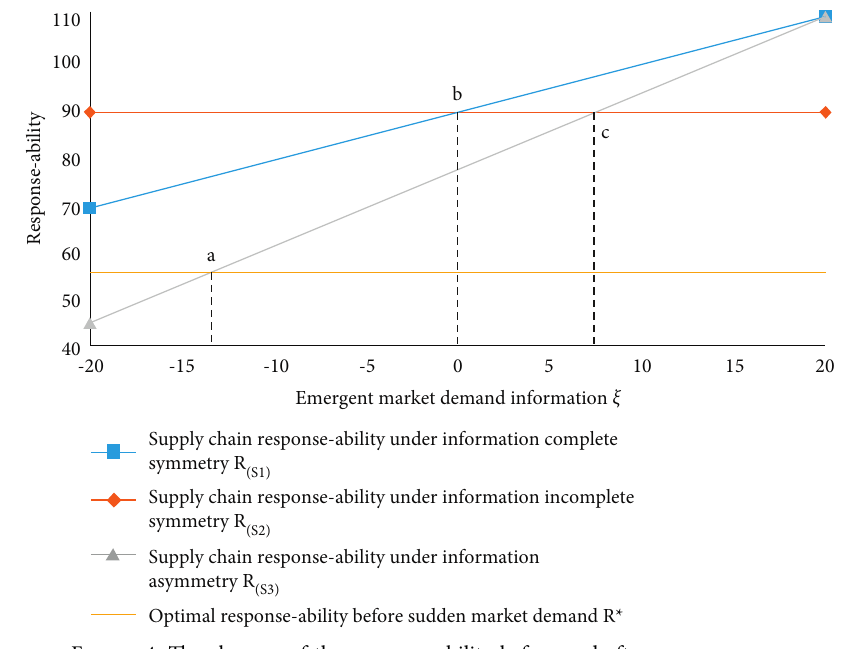
Figure 4: The changes of the response ability before and after an